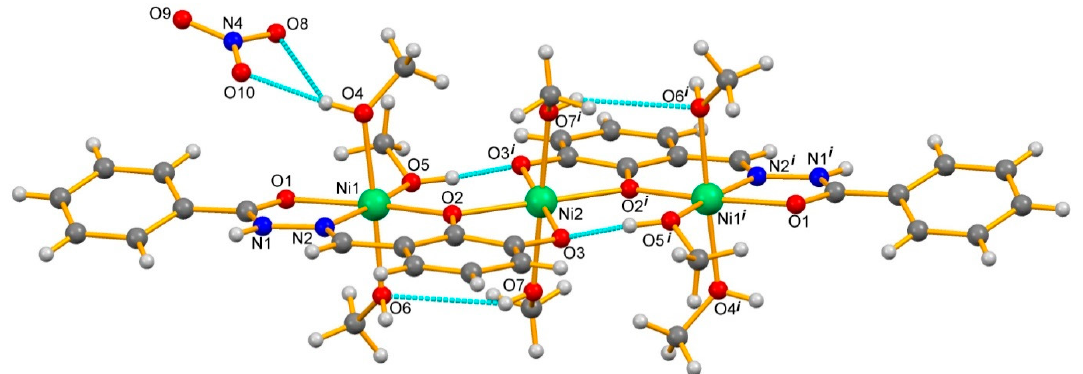
Figure 2. Molecular structure of compound 2 with atom numbering scheme. Sky-blue doted lines represent hydrogen bonds. Symmetry code (i) 1 − x , 1 − y , − z